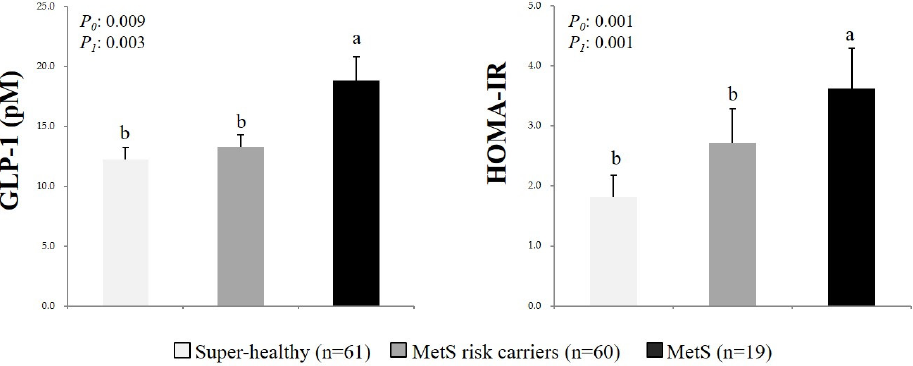
Figure 1. Circulating glucagon-like peptide-1 (GLP-1) levels and homeostasis model assessment insulin resistance (HOMA-IR) scores in the study participants according to MetS status. Mean ±